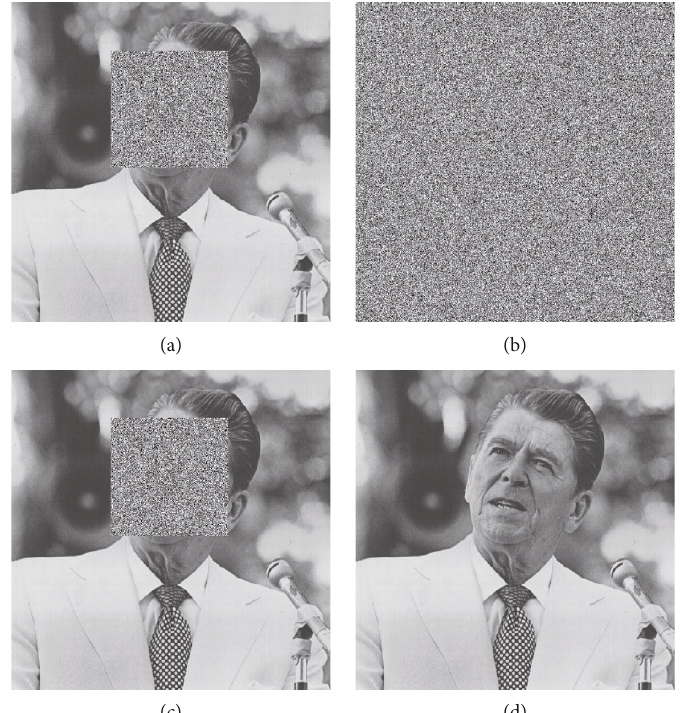
Figure 7: Visualization for Reagan. (a) First encryption. (b) Second encryption. (c) Decrypt for the fi rst time. (d) Decrypt for the second time.